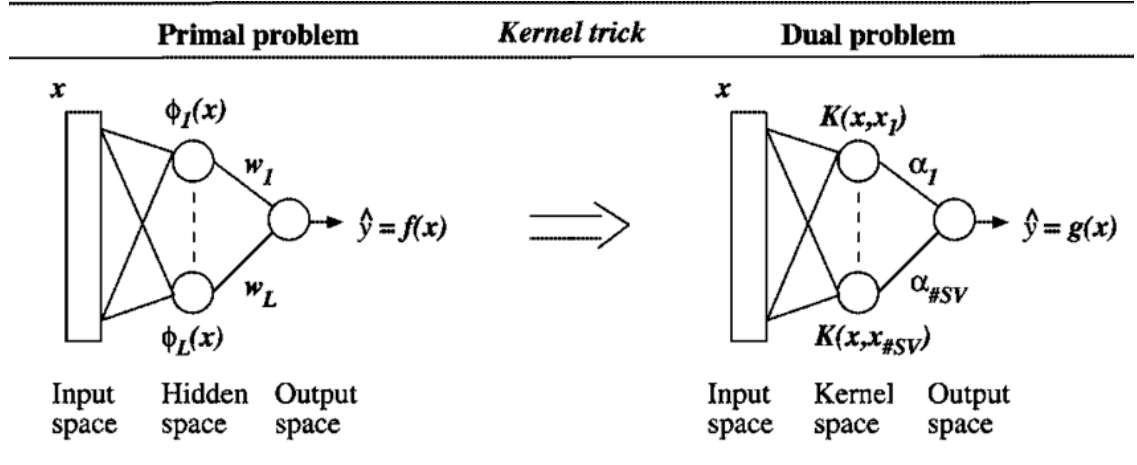
Figure 4. ANFIS model and its nodes.